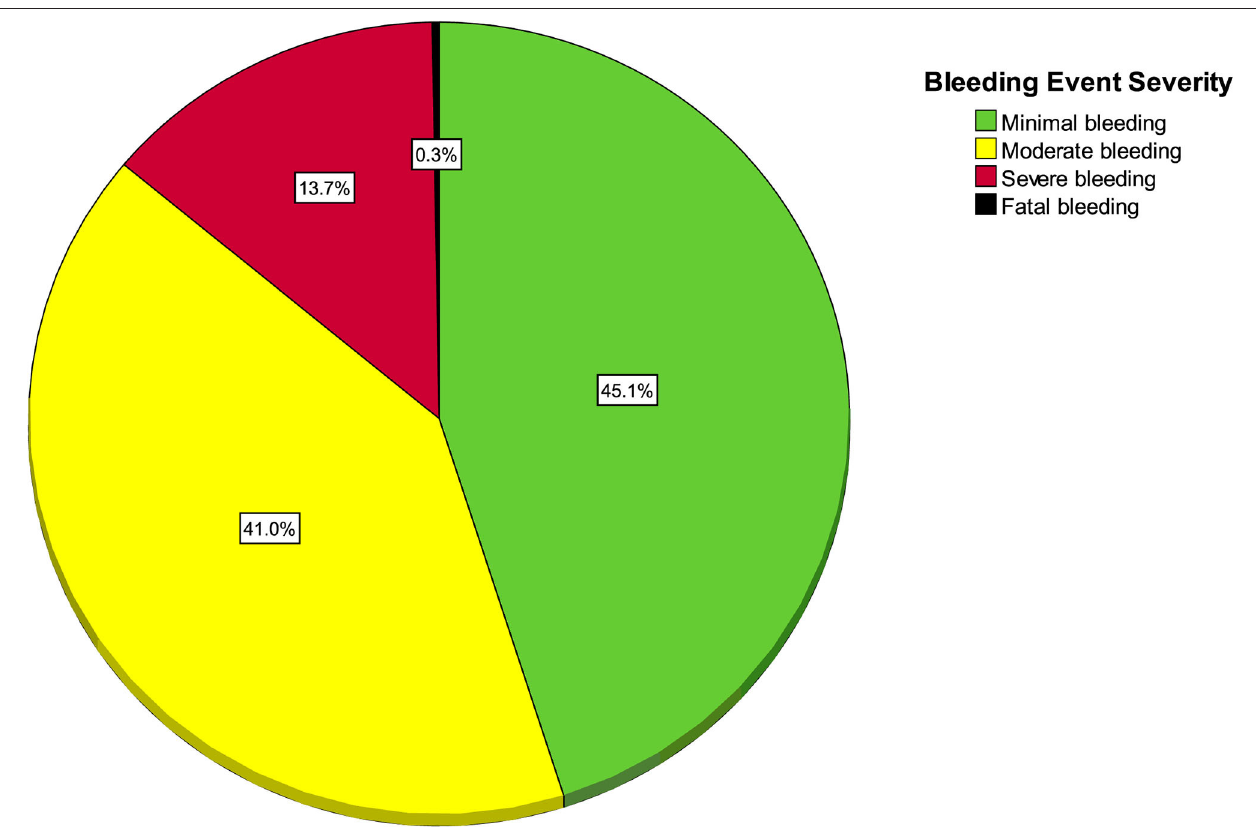
FIGURE 2 | Pie chart of bleeding severity of each event ( n = 366 bleeding